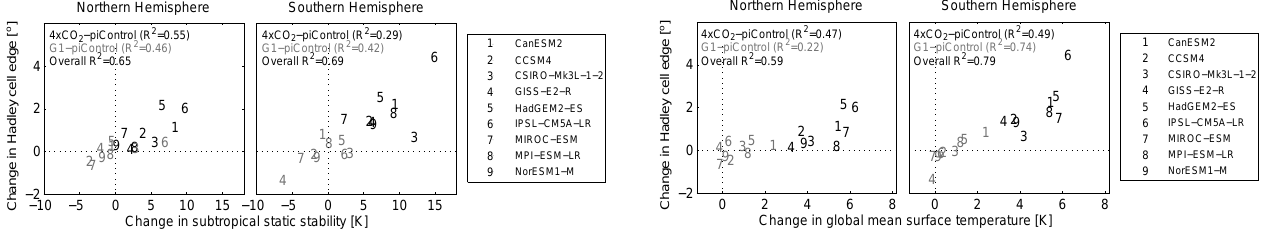
Figure 7. The change in the Hadley cell edge latitude versus the change in subtropical static stability in the Northern Hemisphere and in the Southern Hemisphere. For both hemispheres, positive changes in the Hadley cell edge latitude indicate poleward expan- sion. Shown are values for the 4 × CO 2 experiment minus the pi- Control experiment (black) and for the G1 experiment minus the piControl experiment (gray). The percent of the inter-model vari- ation in the change in the Hadley cell edge latitude explained by the change in subtropical static stability between each experiment is indicated in each plot.